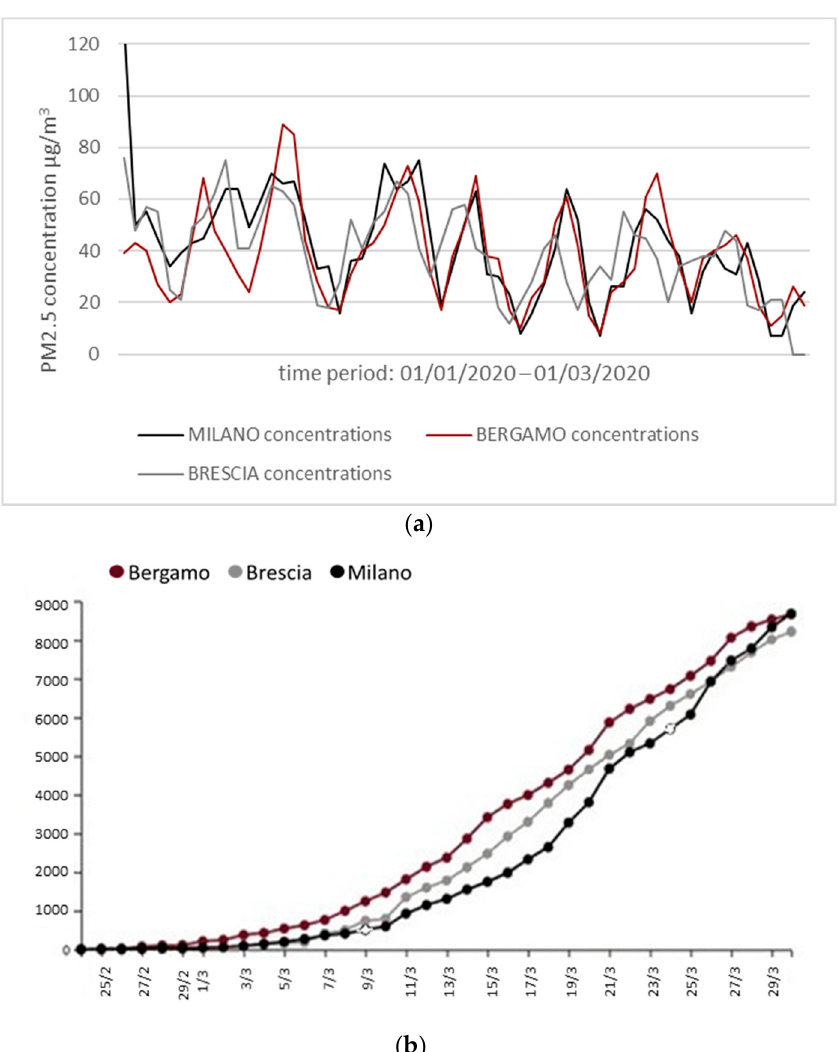
Figure 4. (a) Graph showing a comparison between PM2.5 concentrations in Bergamo, Brescia, and Milan during January and February 2020. (b) Covid-19 positive’s growth in Bergamo, Brescia, and Milan from late February to late March 2020 (generated and modified from [46]). Milan from late February to late March 2020 (generated and modified from